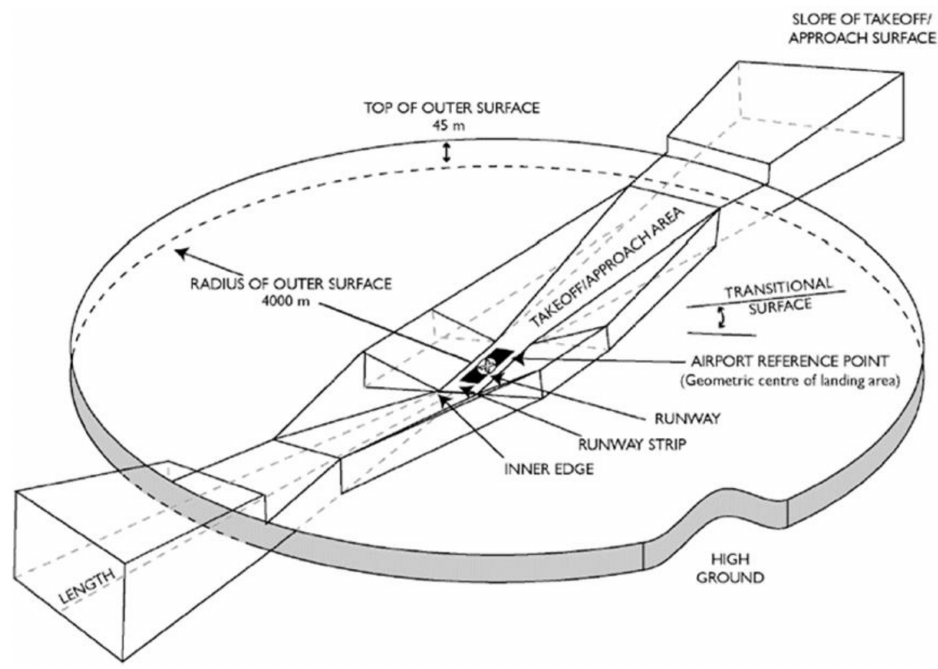
Figure 1. Obstacle Limitation Surfaces (OLSs)